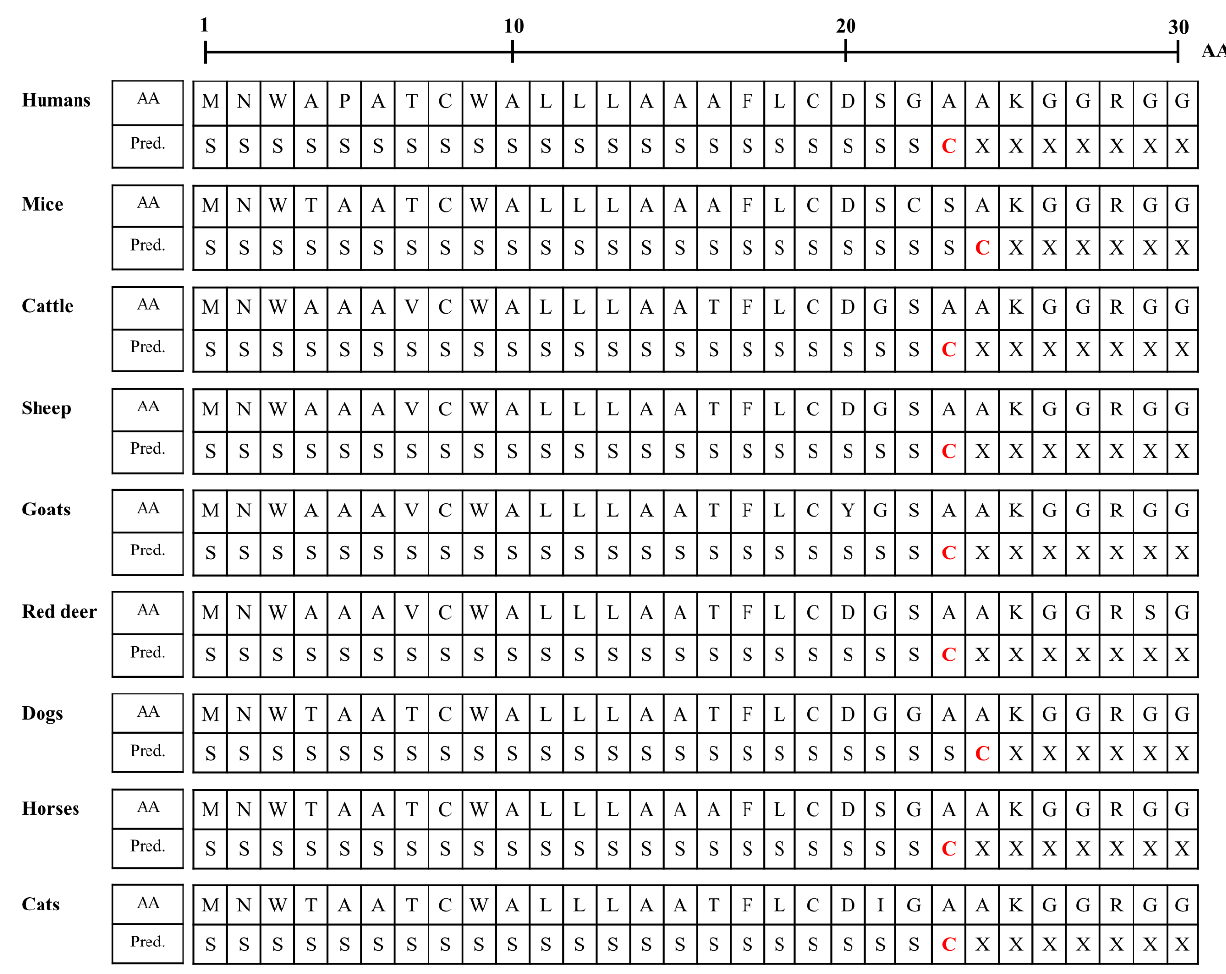
Figure 4. Signal peptide predictions of amino acid sequences of Sho protein in human, mouse, cattle, sheep, goats, red deer, dog, horse and cat. AA: amino acids; Pred.: prediction; S: signal peptide; C: cutting site; X: non-signal peptide.